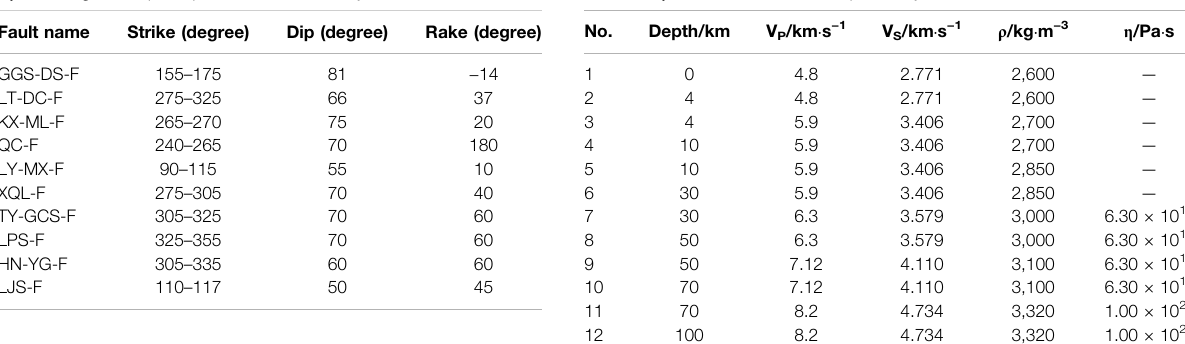
TABLE 1 | Receiving fault rupture parameter in this study. TABLE 2 | Parameters of the lithospheric-layered structure